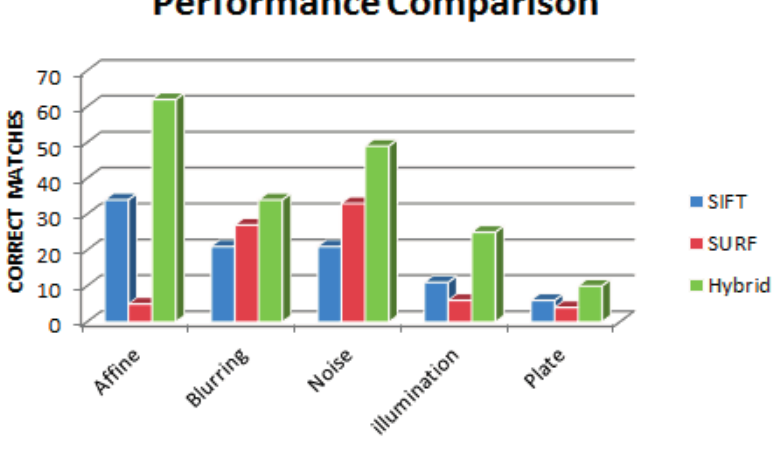
Figure 4. Affine, Blur Noise, Illumination and Plate test cases.